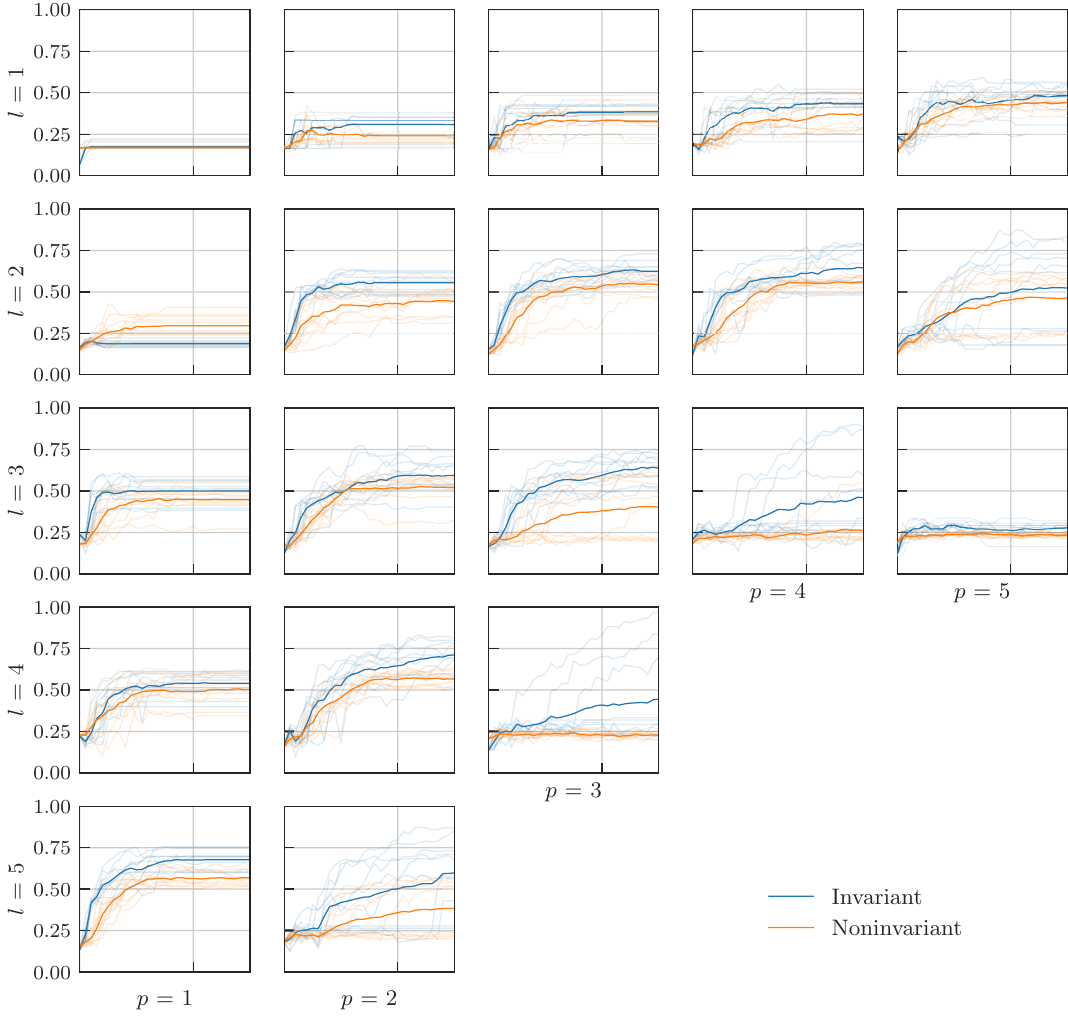
FIG. 15. Plots of the sweep over different values of l and p for the classification of autonomous vehicle scenarios arranged in a grid. Shown on the y axis is the mean test accuracy for the invariant (blue) and noninvariant (orange) models, where the average over the ten runs is plotted in a darker color. Models are composed of l layers, each of which contains one data encoding followed by p times the standard layout “cemoid.” Optimizations are performed for 30 steps with no epochs on the same training set of 60 situations that are chosen randomly at the start of each simulation. The accuracies are evaluated after each step on a test set of 130 random but unique situations, which is fixed throughout a simulation. We can see that the invariant model clearly outperforms the noninvariant model. Additionally, it can be explicitly observed that, for high ( l , p ) values, the expressivity is empirically too high as accuracies drop sharply for both models. Not simulated are circuits for the values ( 4, 4 ) , ( 4, 5 ) , ( 5, 3 ) , ( 5, 4 ) , and ( 5, 5 ) due to their growing computational complexity. Further details can be found in the main